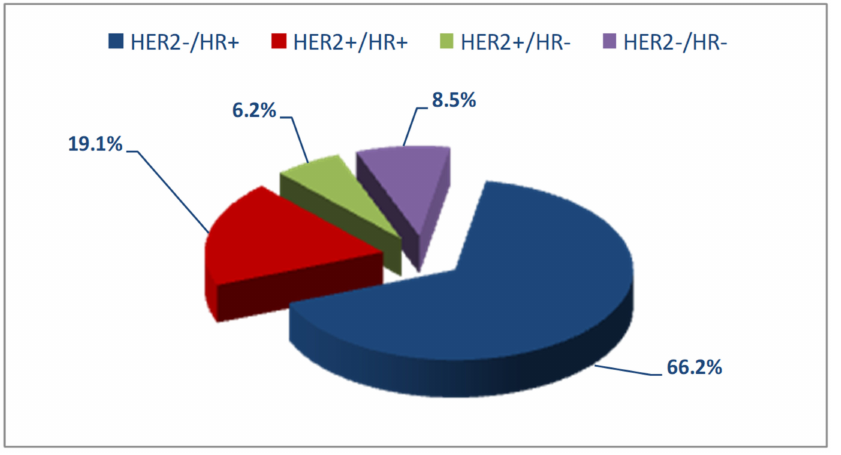
Figure 2. Distribution of molecular subtypes in the study